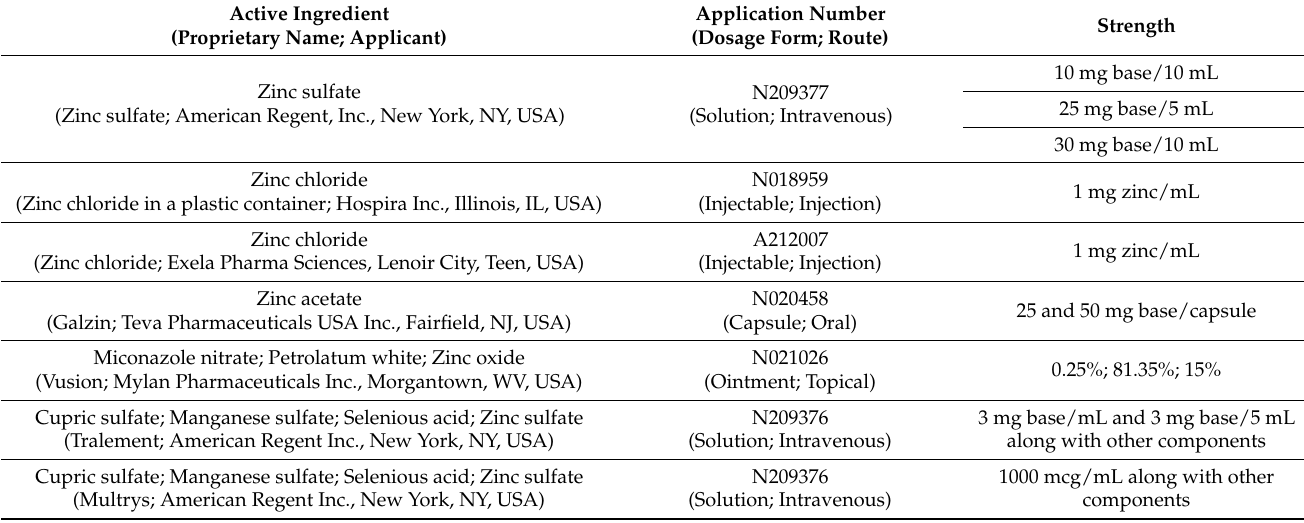
Table 2. USFDA-approved zinc prescription